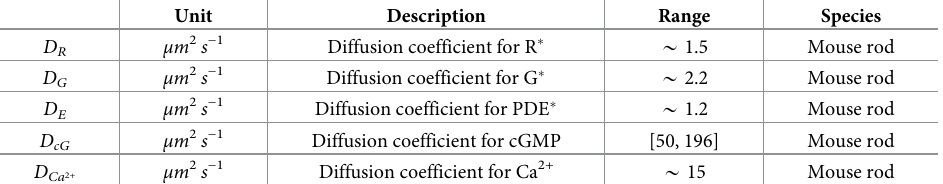
Table 6. Diffusion coefficients for cascade components in the membrane and for second messengers in the cytoplasm.